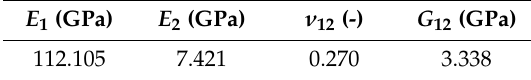
Figure 1. Geometry of the DCB specimen. Table 1. Laminate configurations.